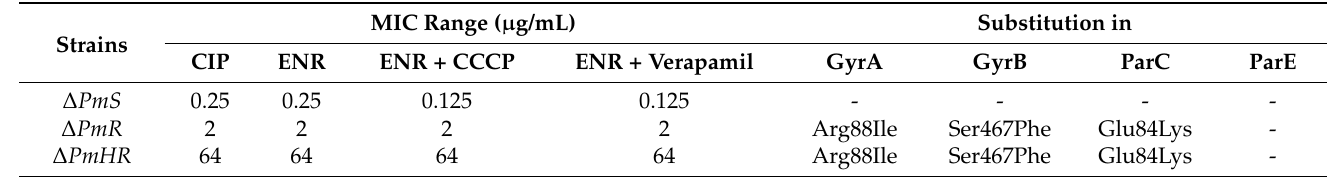
Table 2. QRDR mutation genotypes and fluoroquinolone MICs for ∆ PmS , ∆ PmR and ∆ PmHR